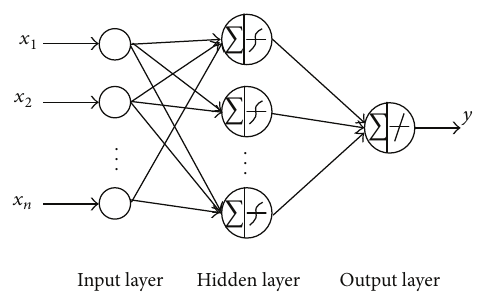
Figure 4: The structure of feed-forward neural